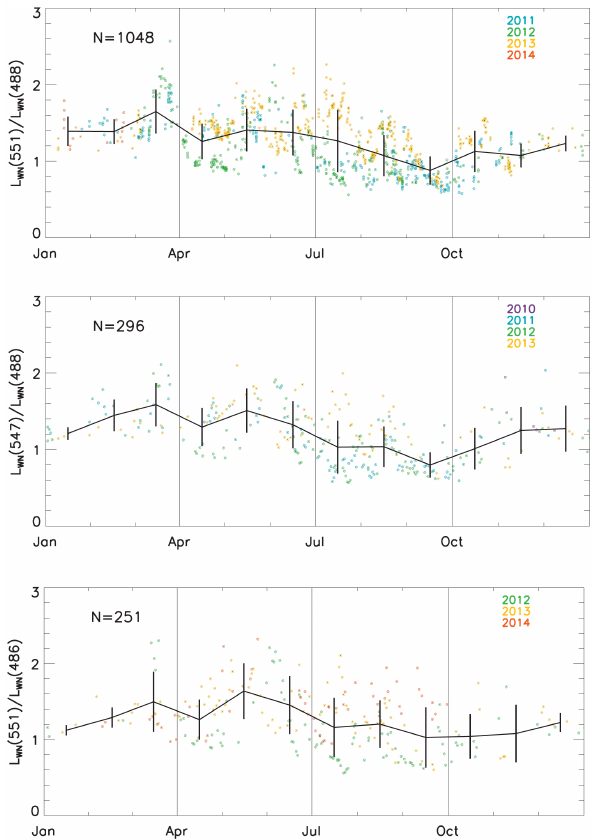
Figure 8. Annual climatology at GLR for the ratios L WN ( 551 )/L WN (488) for AERONET-OC (upper panel), L WN ( 547 )/L WN (488) for MODIS-A (central panel) data, and L WN ( 551 )/L WN (486) for VIIRS (lower panel), determined with all available data for the period 2010–2014. The thick black line indicates monthly averages, while vertical bars indicate ± 1 standard deviation. N is the number of